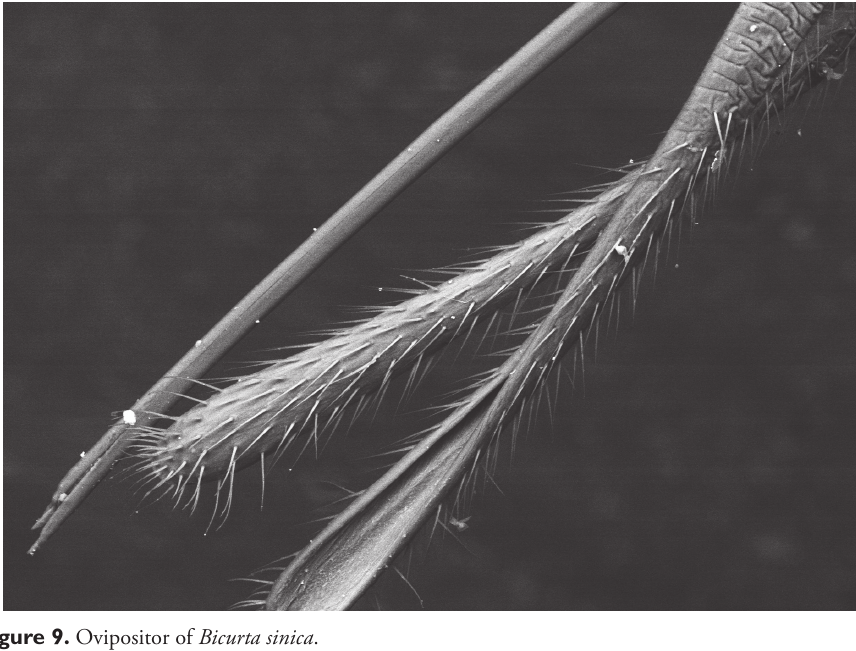
Figure 9. Ovipositor of Bicurta sinica .